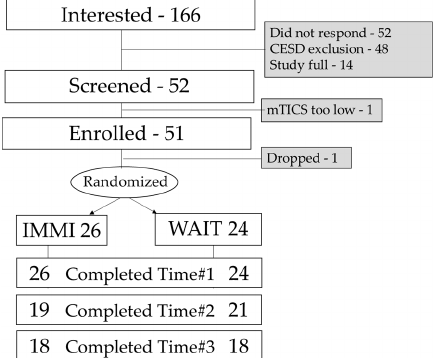
Figure 2. Recruitment diagram. IMMI, Internet Mindfulness Meditation Intervention; WAIT, waitlist control group; CESD, the Center for Epidemiologic Studies Depression Scale; mTICS, Modified Telephone Interview for Cognitive Status.